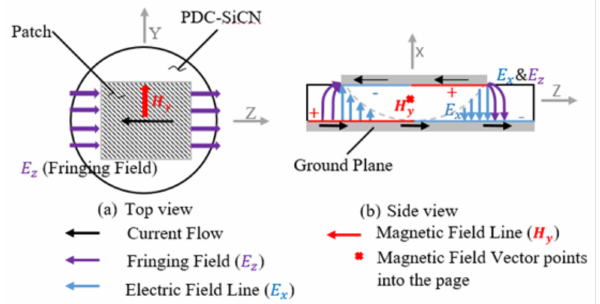
Figure 9. Electric and magnetic fields of the PDC patch antenna